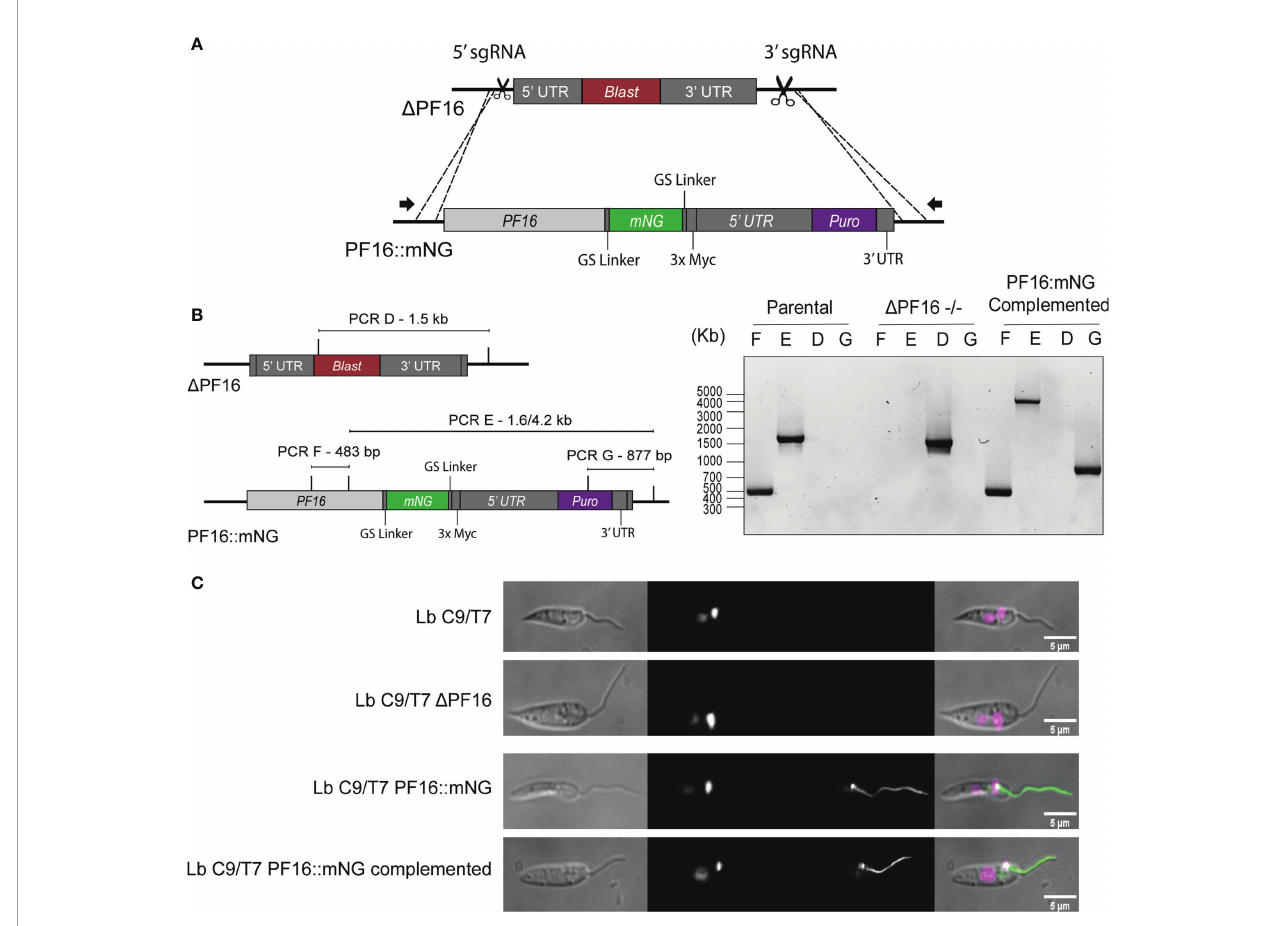
FIGURE 6 | Schematic representation of the in-locus complementation strategy. (A) Two sgRNAs (scissors) at the 5 ′ and 3 ′ ends of the pTBLAST cassette insertion sites were used to direct Cas9-mediated DSB in Lb C9/T7 D PF16 cell line. A donor DNA ampli fi ed from Lb C9/T7 PF16::mNG transfectant containing the PF16 CDS fused to mNG (green) and a puromycin resistance marker (purple) was also delivered to mediate DSB repair. (B) Four PCRs (PCR-D, PCR-E, PCR-F, and PCR-G) were performed to screen for the presence or absence of PF16 CDS (PCR-E and PCR-F) and blasticidin resistance gene (PCR-D) in the parental line (Lb C9/T7), in the PF16 di-allelic knockout line ( D PF16 − / − ), and in the complemented cell line. Electrophoresis in 1% agarose gel showed the ampli fi cation of a 483-bp fragment (PCR-F) and a 1.6- or 4.2-kb fragment (PCR-E) in parental and add-back lines, respectively, relative to the presence of PF16 CDS. Ampli fi cation using a forward primer annealing in the blasticidin resistance marker was only observed in the genomic DNA of the knockout cell line, and ampli fi cation using a forward primer annealing inside the puromycin resistance gene was only observed in the complemented cell line. (C) Imaging of cell lines generated in this study: parental (Lb C9/ T7), knockout Lb C9/T7 D PF16, tagged (Lb C9/T7 PF16::mNG), and complemented (Lb C9/T7 PF16::mNG complemented). Each column shows phase contrast, Hoechst (DNA), mNeonGreen (tagged CDS), and merged channels,